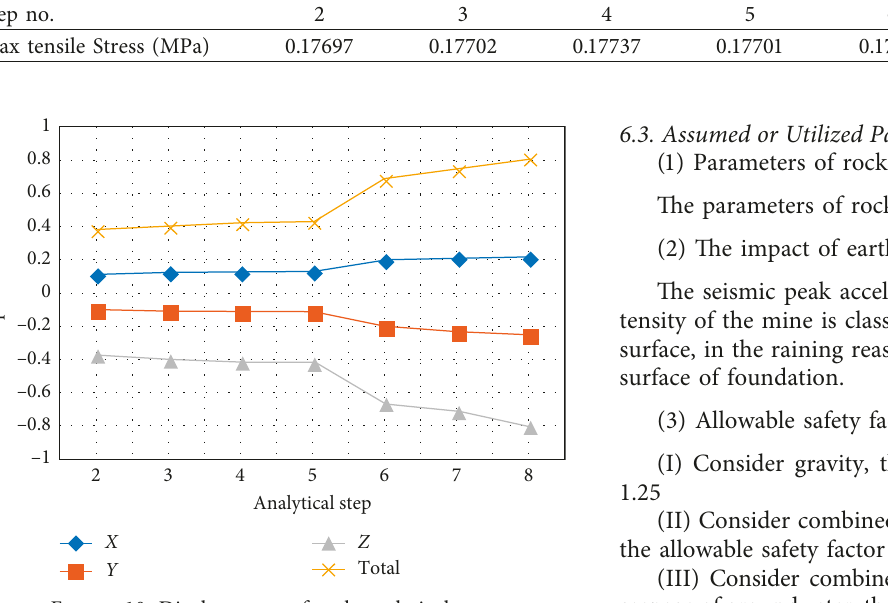
Figure 10: Displacement of each analytical